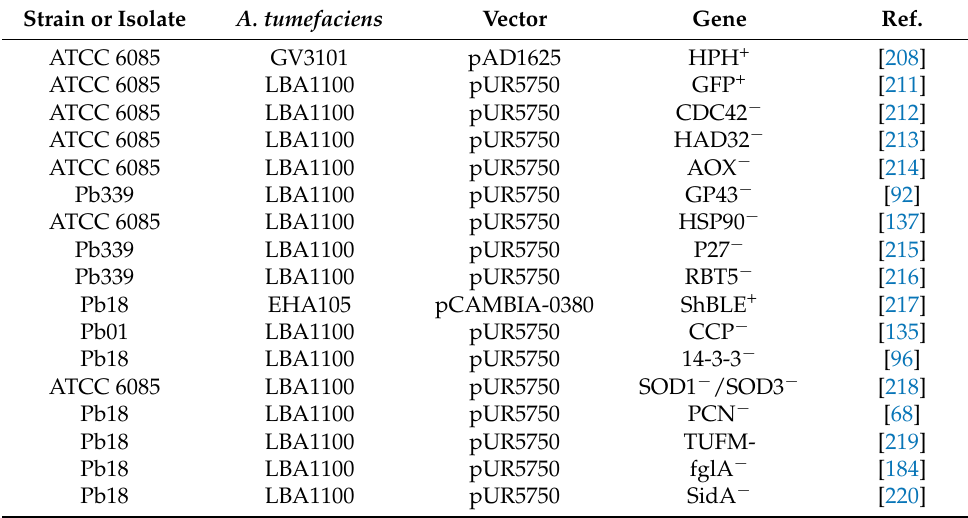
Table 1. Genetic studies of Paracoccidioides published up to 2020. Strain or